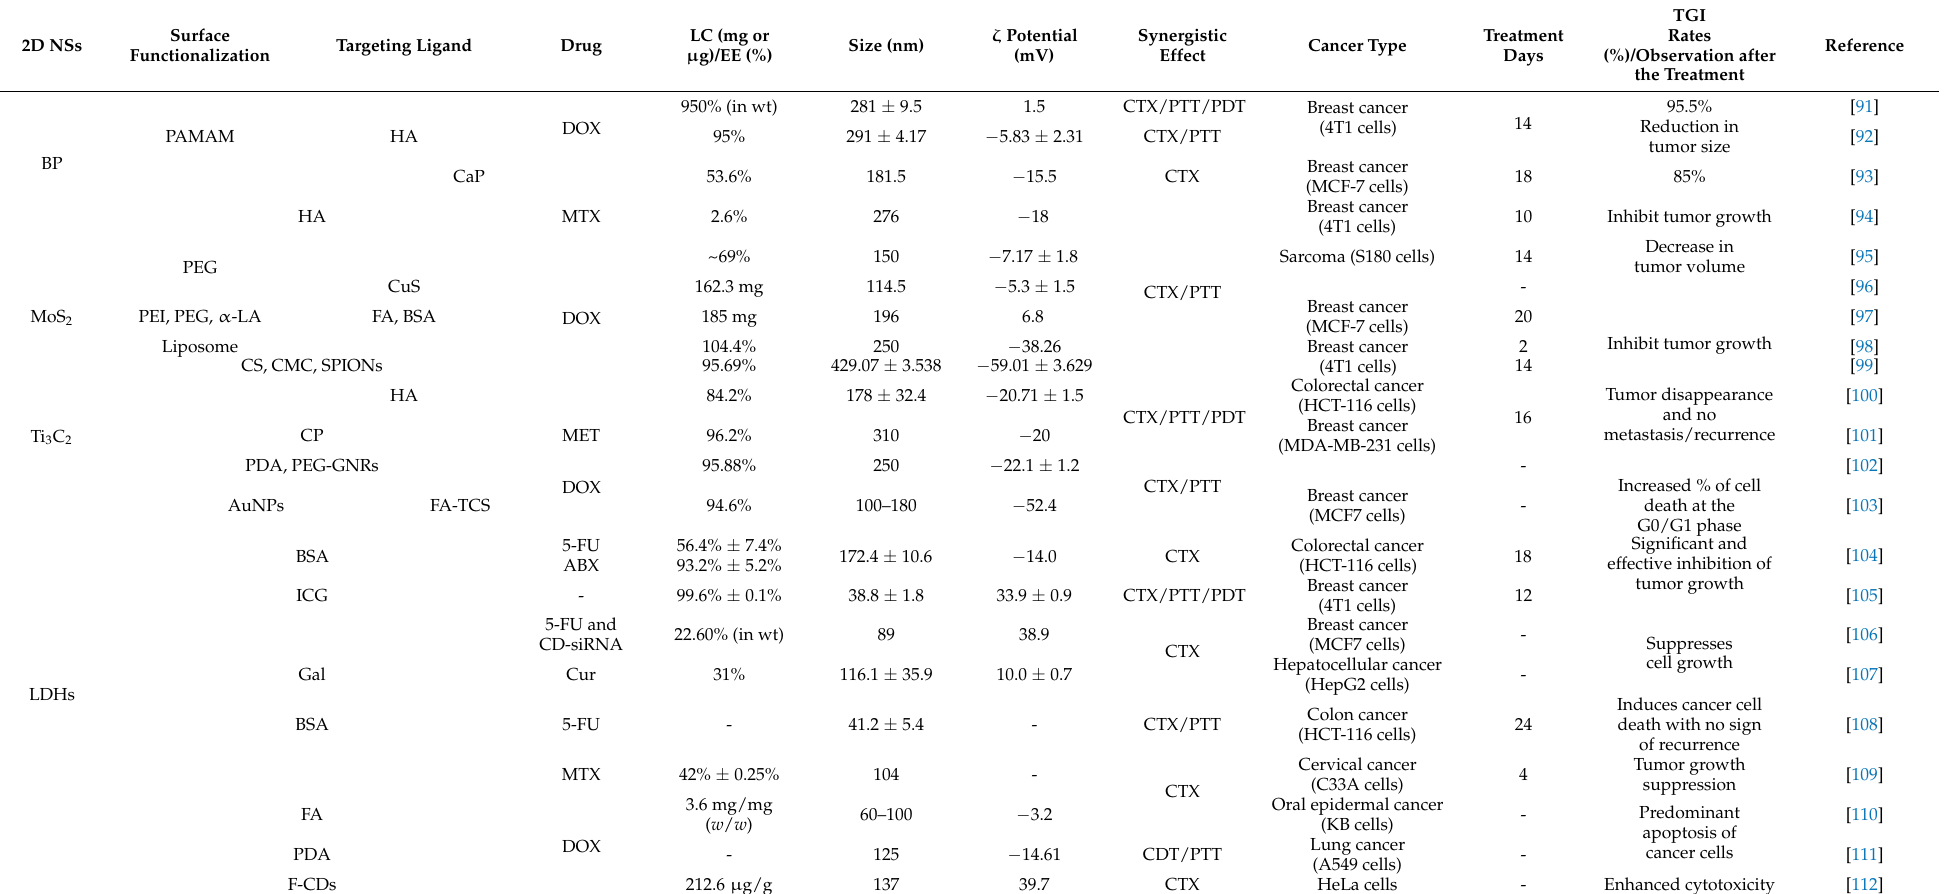
Table 1. Some of the recent advances in various NSs as DDSs along with surface functionalization, targeting ligand, drugs employed, their characteristics, treated cancer types, days, and their interpretations for multimodal cancer